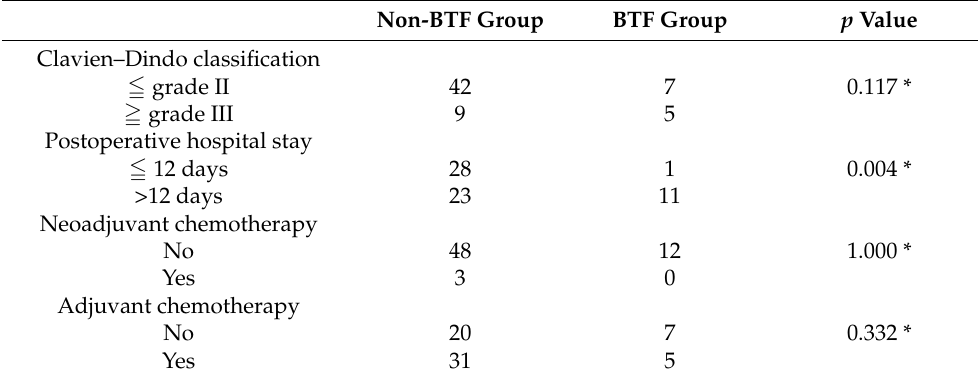
Table 4. Short-term postoperative